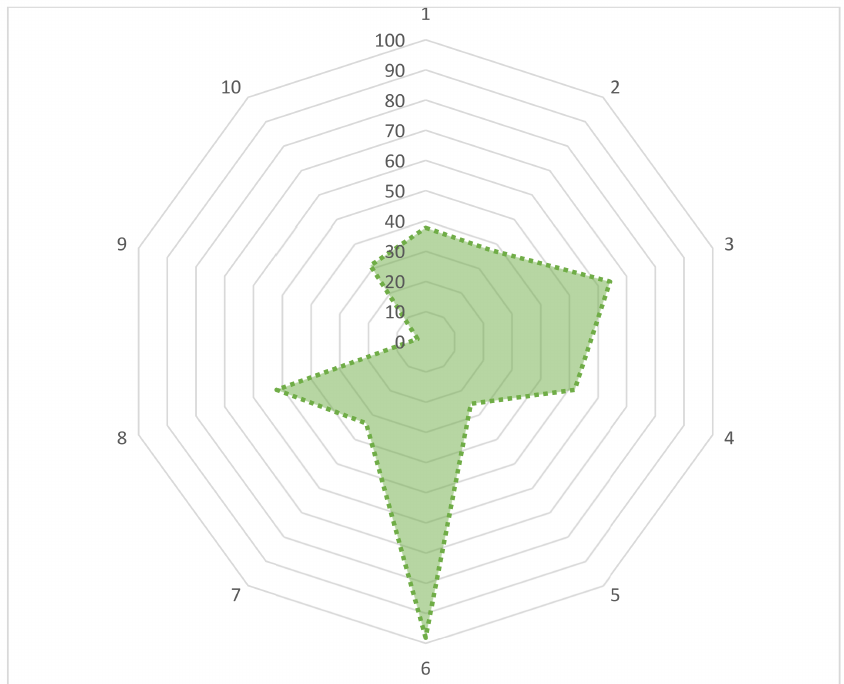
Figure 4. The distribution of appropriate practices among farmers for various questions in the study questionnaire. (1) Who recommended you antibiotics? (Veterinarian/other farm- ers/shopkeepers/representative of pharmaceutical company/veterinary paraprofessional/village doctor/ quack/self). (2) Do you keep a record of using antimicrobials? (Always/most fre- quently/sometimes/rarely/never/do not know). (3) Did you complete the antibiotic course the